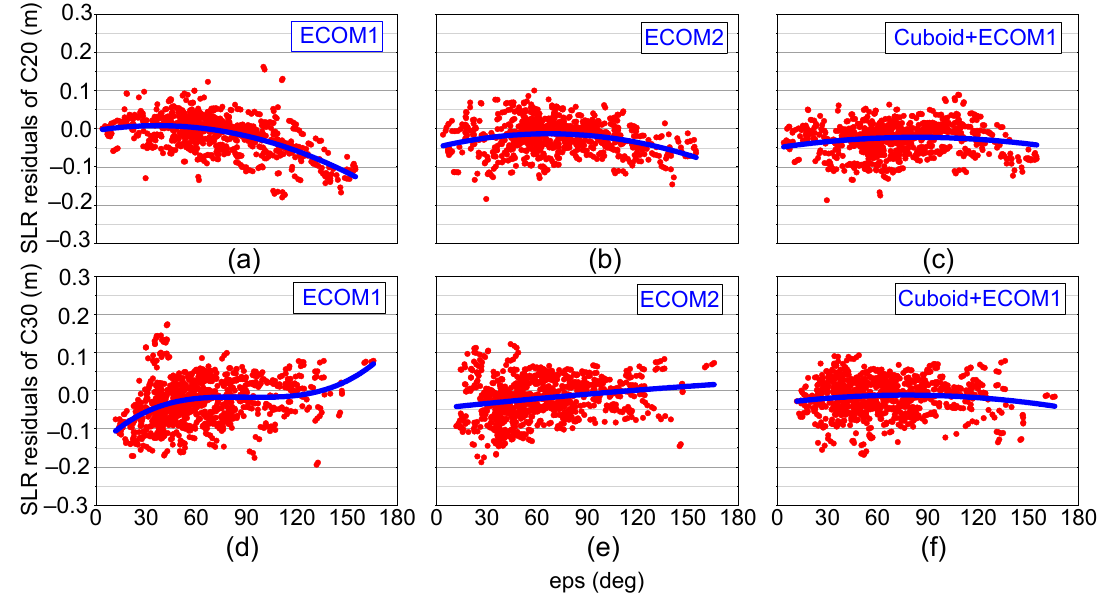
Figure 7. One-way satellite laser ranging (SLR) residual of the BeiDou-3 satellites. ( a ) and ( d ) are the ECOM1 results of C20 and C30, ( b ) and ( e ) are the ECOM2 results of C20 and C30, and ( c ) and ( f ) are the Cuboid + ECOM1 results of C20 and C30. The blue line is the cubic polynomial fitting curve of the SLR residuals. Compared with the RMS of the SLR residuals of the ECOM1 model, shown in Table 8, for the CAST’s satellites, the STD was improved by about 0.78 cm (15.4%), and the RMS was slightly